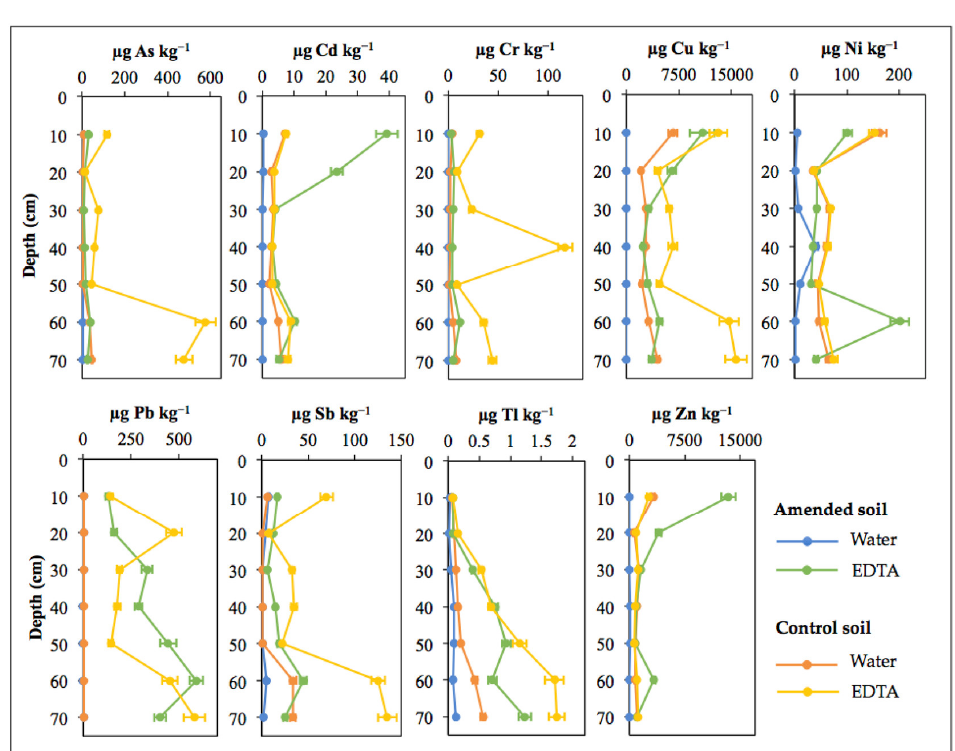
Figure 8. Vertical distribution of trace element concentrations extracted by deionized water and EDTA from the two sampling sections (amended and control) of the soil profile.